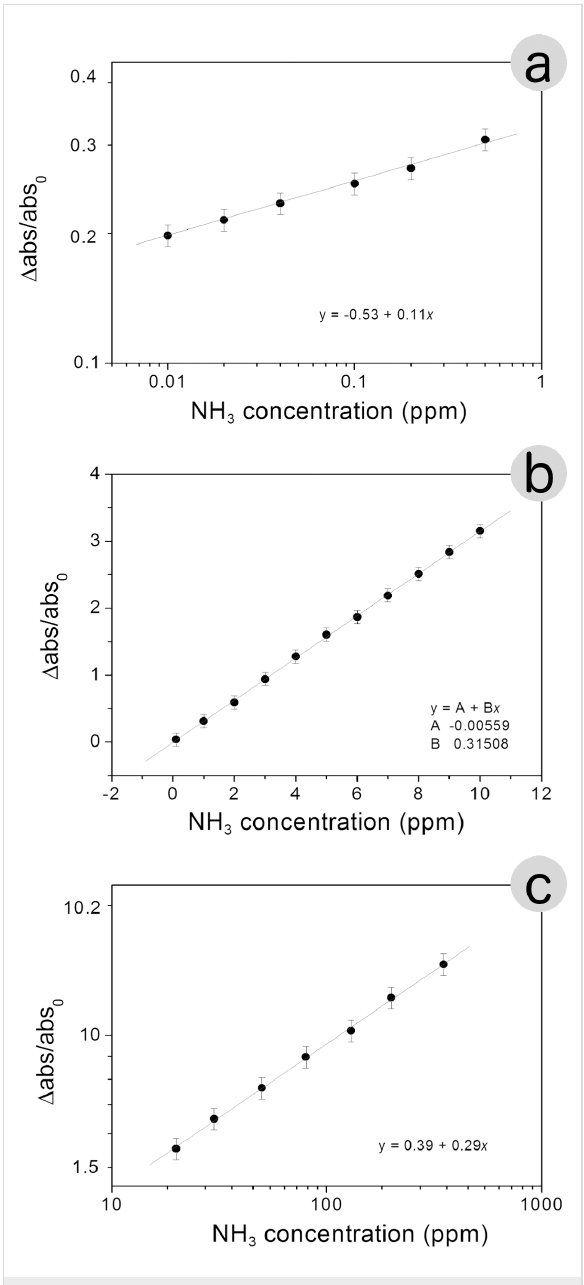
Figure 7: Three distinct regimes of absorbance as a function of the NH 3 concentration: (a) very low concentrations from 0.01 to 0.2 ppm, (b) intermediate or physiological concentrations from 0.5 to 10 ppm, (c) high concentrations from 20 to 350 ppm.